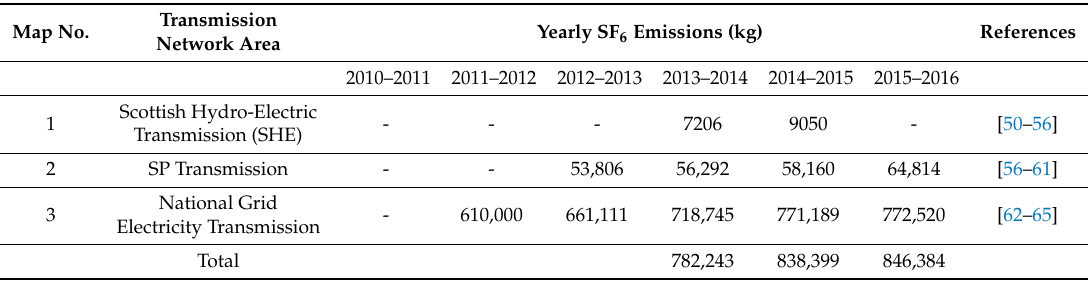
Table 9. Estimated SF 6 Inventory on each transmission network area (kg) in Great Britain. Map No.